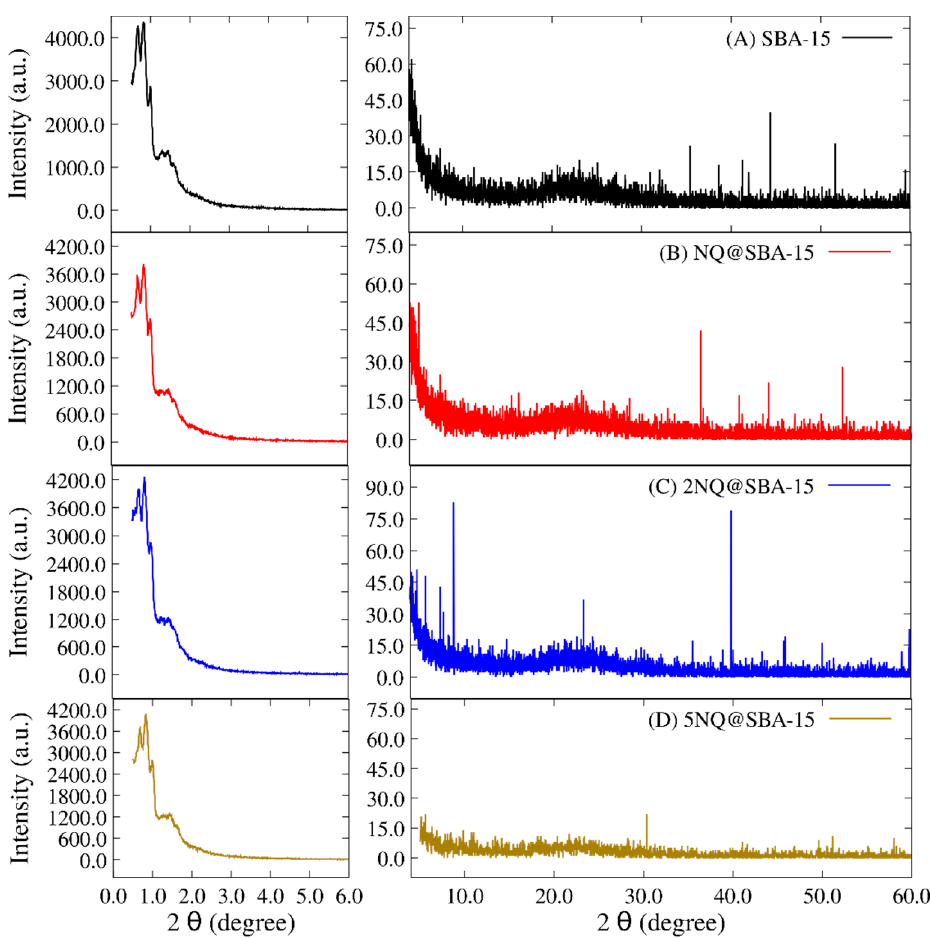
Figure 2. XRD patterns of SBA-15 loaded with NQs. ( A ) SBA-15, ( B ) NQ@SBA-15, ( C ) 2NQ@SBA-15, and ( D ) 5NQ@SBA-15.